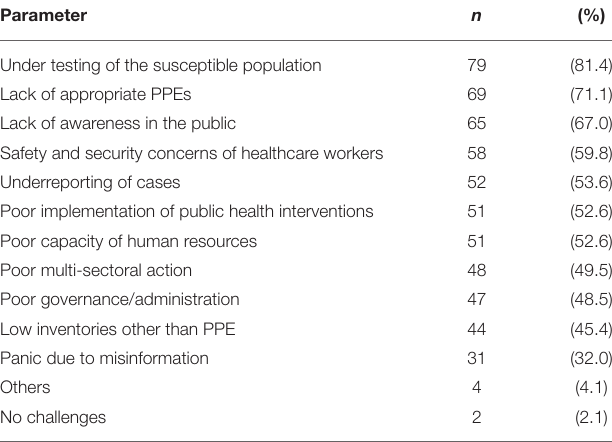
TABLE 4 | Challenges faced during the countries in control of COVID-19